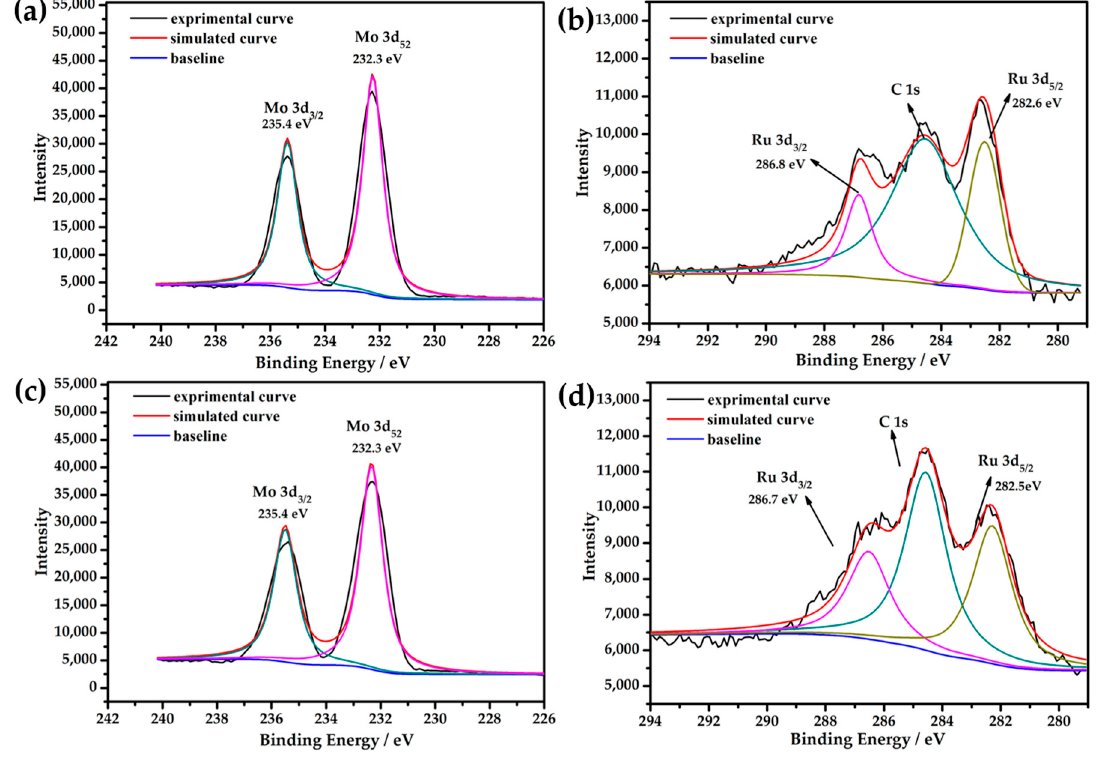
Figure 5. The XPS spectra for the catalyst: ( a ) Mo 3d and ( b ) Ru 3d before reaction; ( c ) Mo 3d and ( d ) Ru 3d after the tenth run of the reaction. Spectral analysis was performed using peak-fitting with Gaussian–Lorentzian peak shape and Shirley-type background subtraction, taking as reference the C 1s peak typically at 284.6 eV and the Ru 3d 5/2 , 3d 3/2 double peak with a constant area rule: A(3d 5/2 ) = A(3d 3/2 )/1.5 and center position relation χ c (3d 5/2 ) = χ c (3d 3/2 ) + 4.2 eV.